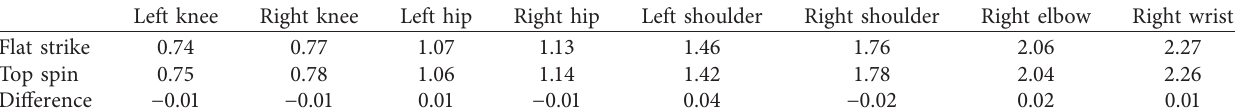
Figure 10: Comparison of spatial characteristics at the lowest point of the shoulder joint in the racket stage. Table 5: Comparison of spatial characteristics at the lowest point of the shoulder joint in racket stage.